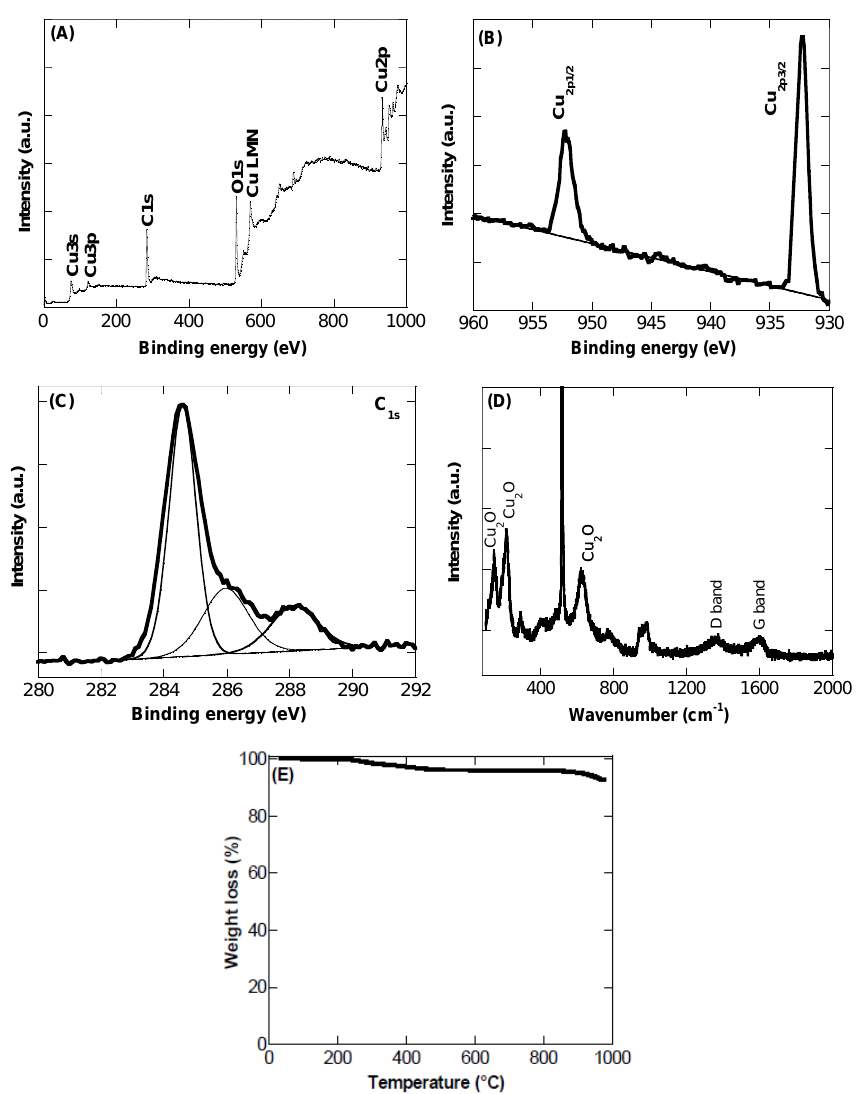
Figure 2. ( A ) X-ray photoelectron spectroscopy (XPS) survey spectrum; ( B ) Cu 2p core level spectrum; ( C ) C 1s core level spectrum; ( D ) Raman spectrum; ( E ) thermogravimetric analysis (TGA) thermogram of CQDs/Cu 2 O nanocomposite.